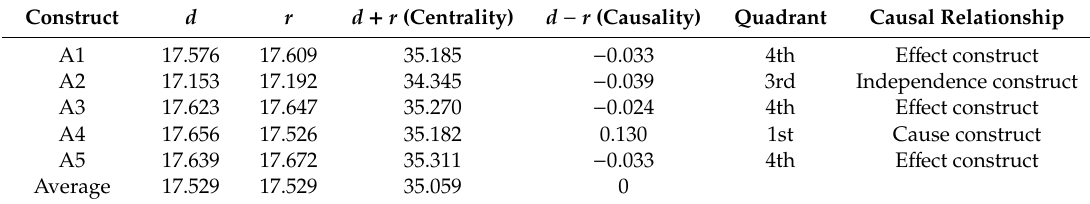
Table 8. The degree of centrality and